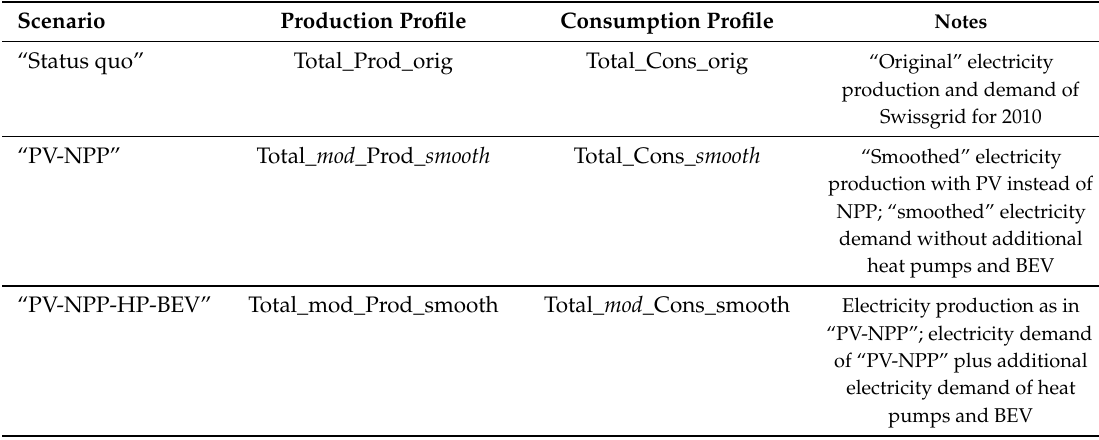
Table 2. Scenarios of this study with their electricity production and consumption (demand) profiles. For the individual profiles refer to Table